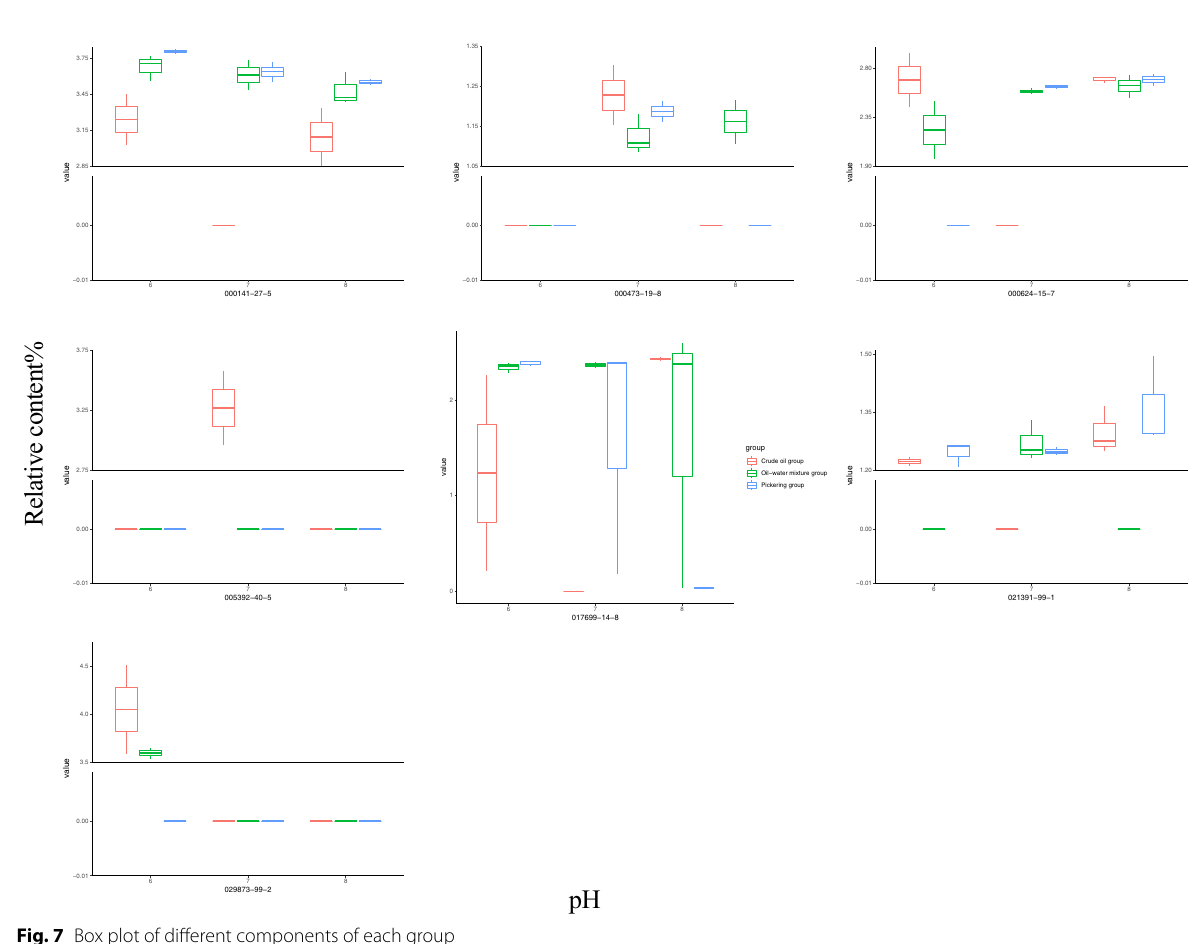
Fig. 7 Box plot of different components of each